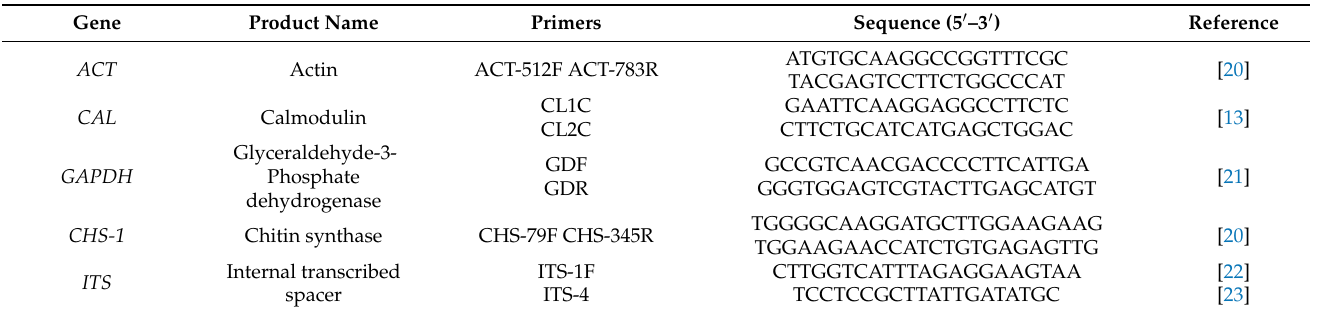
Table 1. Primers used in this study, with sequences and